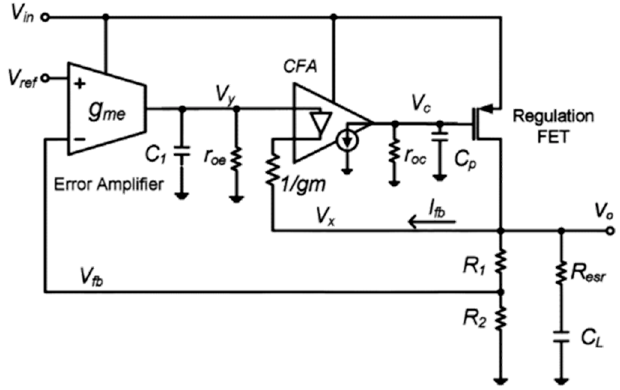
Figure 11. LDO architecture using CFA-based buffer amplifier [19].